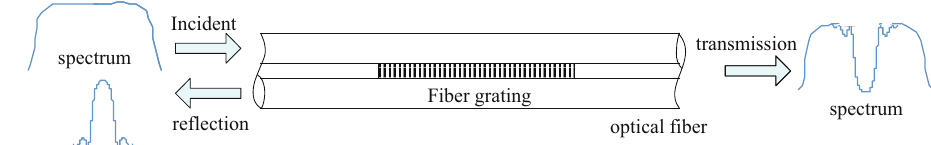
Figure 3: Working principle of FBGs.